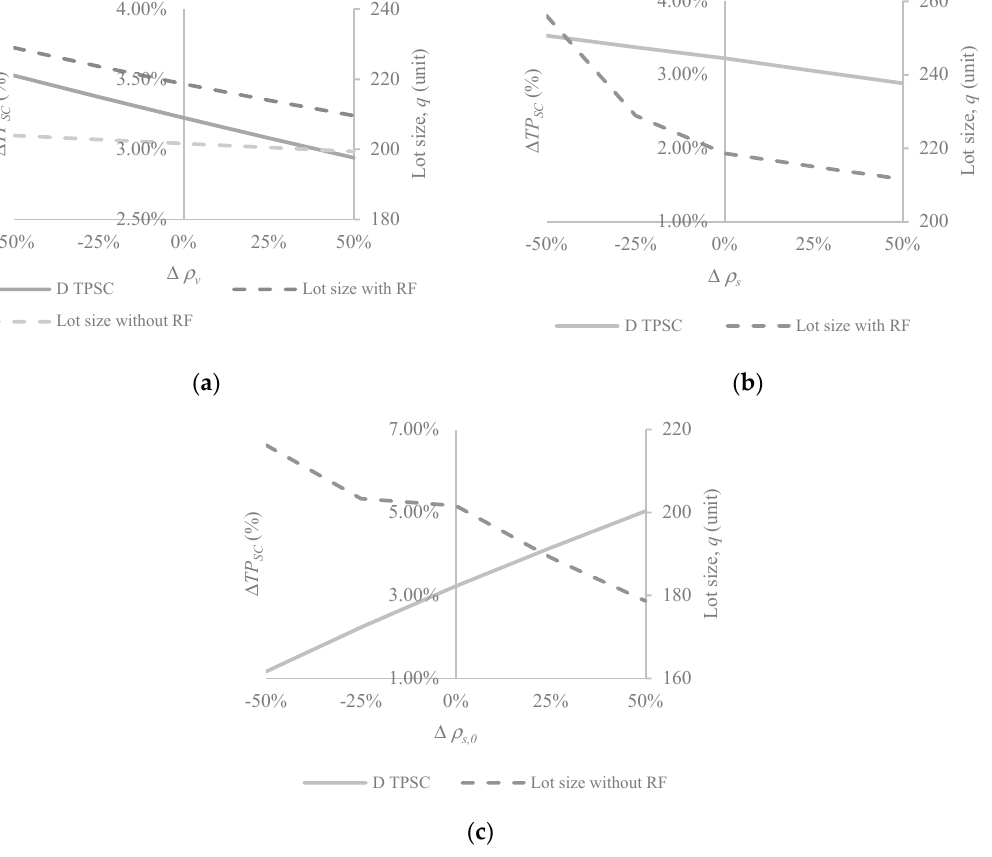
Figure 7. Optimal lot size, and total cost of the supply chain as a function of interest rates: ( a ) of the vendor ρ v , ( b ) of the supplier with reverse factoring ρ s , and ( c ) of the supplier without reverse factoring ρ s ,0